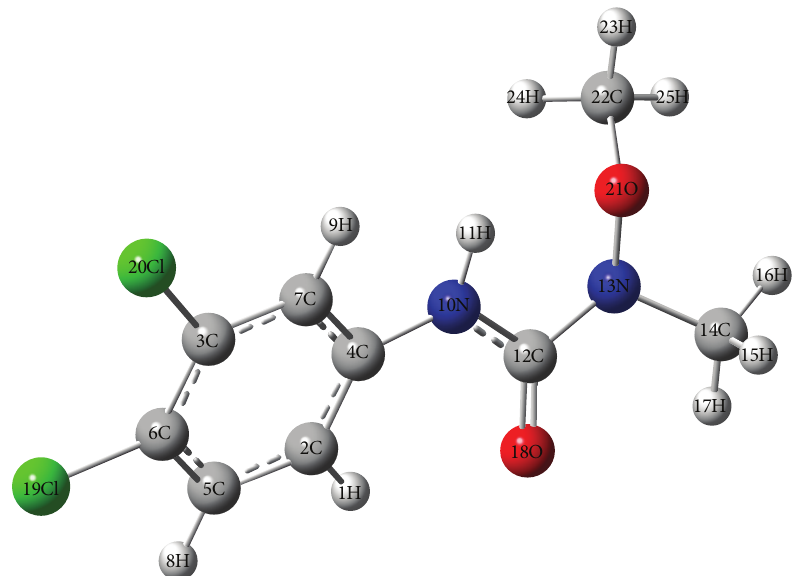
Figure 4: Optimized structure of linuron at the MP2/6-311++G(2d,2p) level of theory. Bond distances: 2C-4C = 1.40, 2C-5C = 1.39, 3C-6C = 1.40, 3C-7C = 1.39, 4C-7C = 1.40, 5C-6C = 1.39, 6C-19Cl = 1.74, 3C-20Cl = 1.74, 4C-10N = 1.40, 10N-12C = 1.37, 12C-18O = 1.23, 12C-13N = 1.40, 13N-21O = 1.42, 13N-14C = 1.46, 21O-22C = 1.44, N-H = 1.00, C-H = 1.09 in methyl groups, and C-H = 1.08 in the ring. Dihedral angle